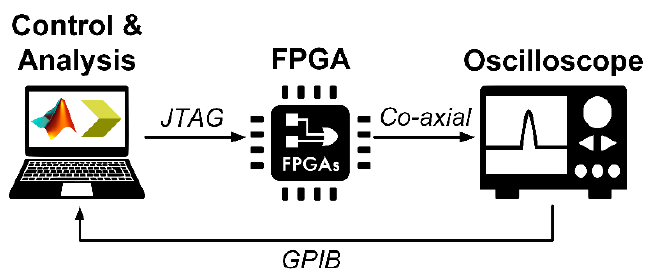
Figure 10. Schematic of IR-UWB pulse generation using the proposed FPGA scheme. Table 2. The specifications of experimental components.